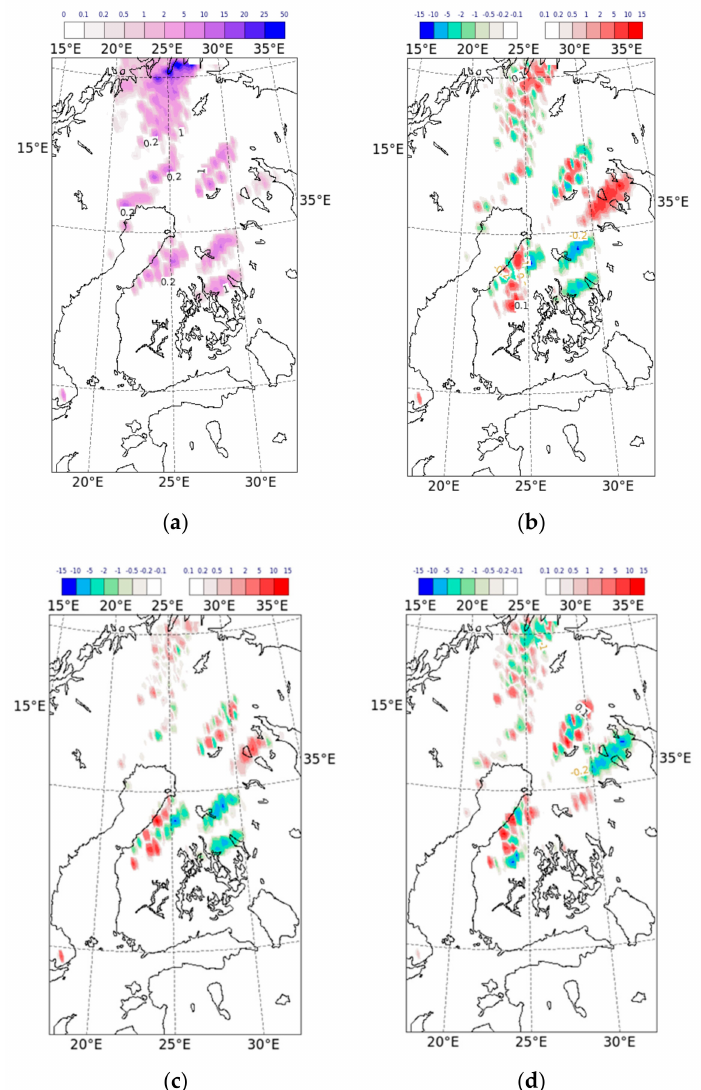
Figure 5. Same as Figure 4, but for surface precipitation.